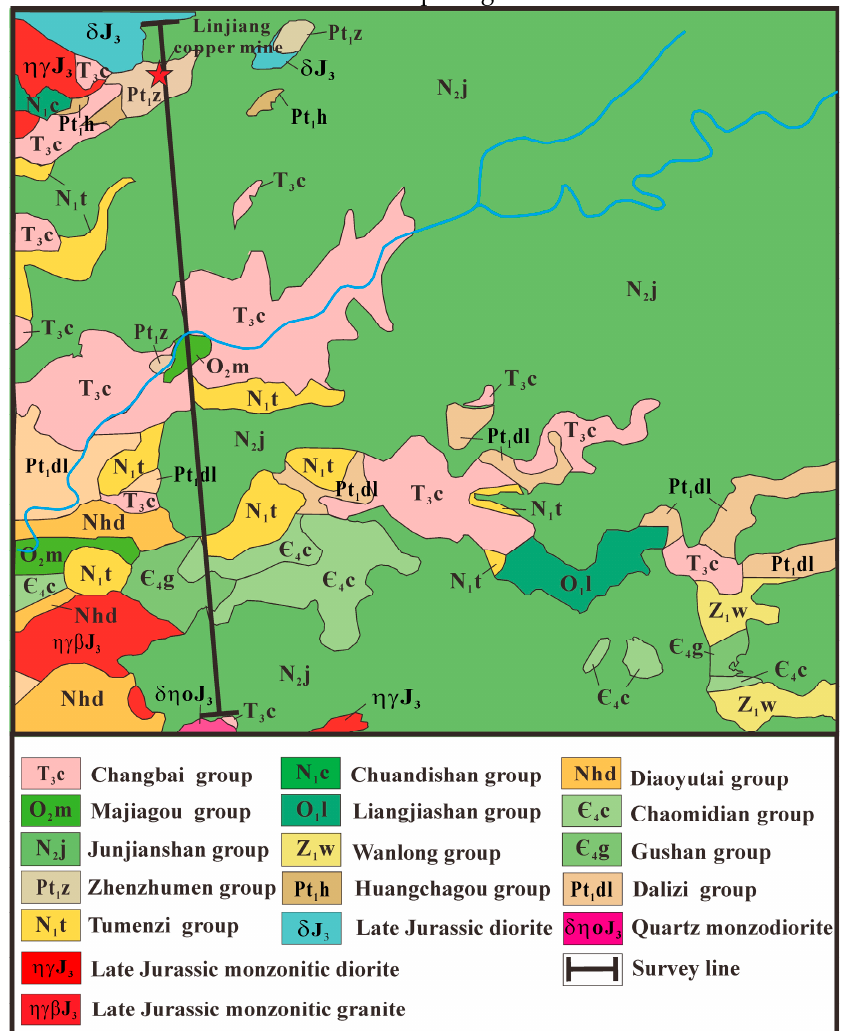
Figure 11. The geological map of the Linjiang copper mining area.